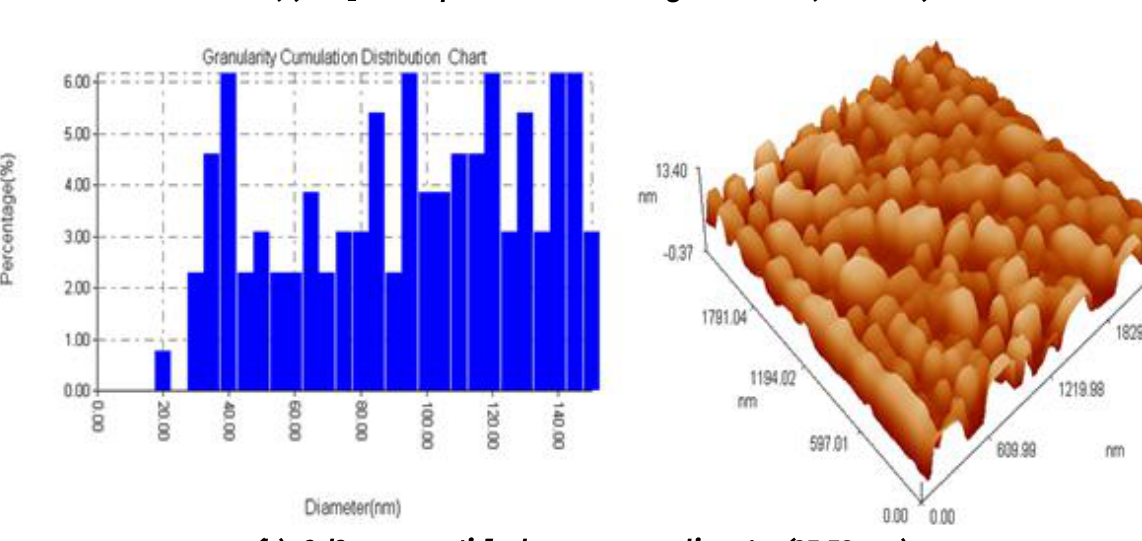
O nanoparticles and (b): is CdO 2 2